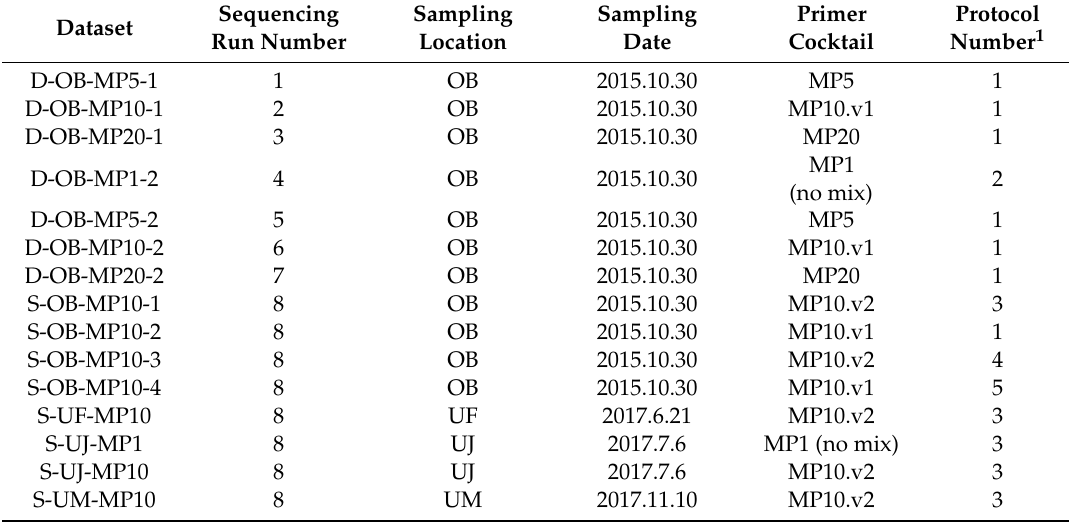
Table 1. Datasets produced in this